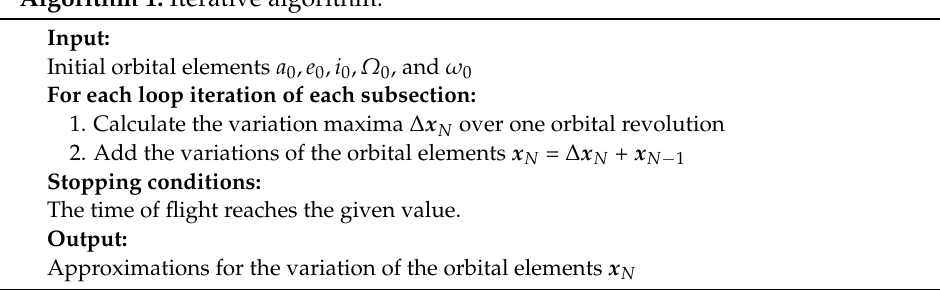
Algorithm 1: Iterative